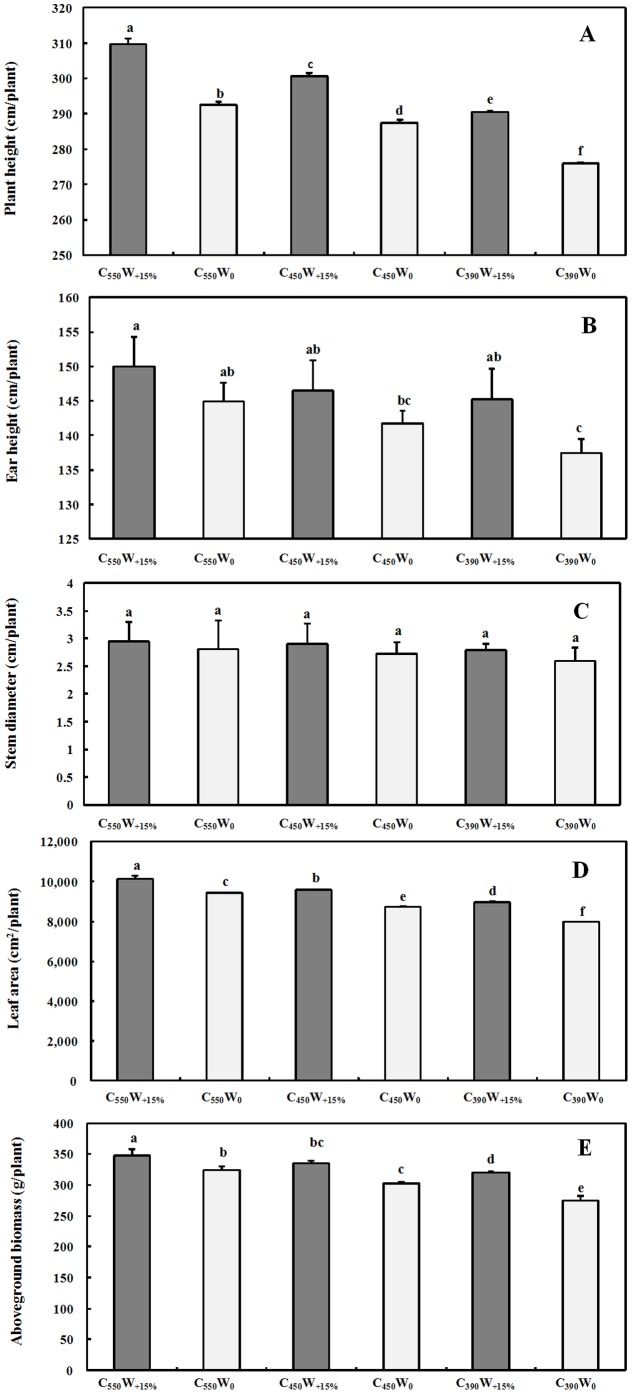
Changes of (A) plant height, (B) ear height, (C) stem diameter, (D) leaf area and (E) aboveground biomass (means ± SD) (n = 3) in six treatments (C550W+15%, C550W0, C450W+15%, C450W0, C390W+15% and C390W0) in silking stage of maize under effects of elevated [CO2] and irrigation.Different lower cases letters indicated significant difference (P<0.05).